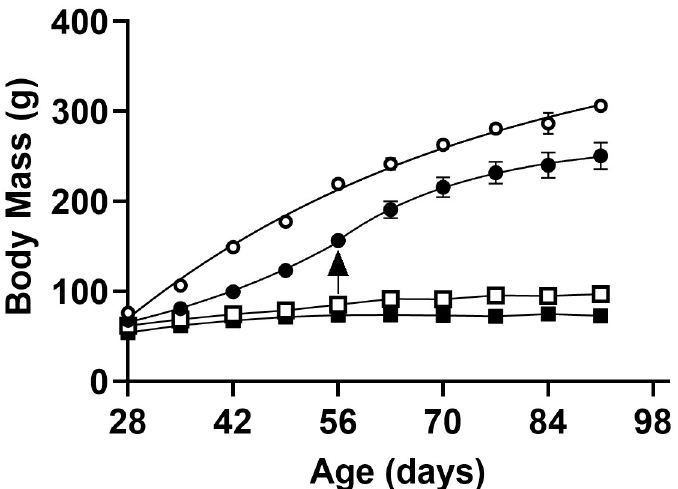
Fig 1. Body mass (BM) development. Rats received the control diet (CTRL) (circles) or the multideficient diet (RBD) (squares) for 64 days from weaning at 28 days until 92 days of age: effect of Losartan (Los) administration for the same period indicated on the abscissae . Dietary composition is described in Table 1. Empty symbols: untreated rats; filled symbols: Losartan-treated rats. Data are mean ± SEM; n = 5 (CTRL), n = 5 (CTRL+Los), n = 8 (RBD), n = 6